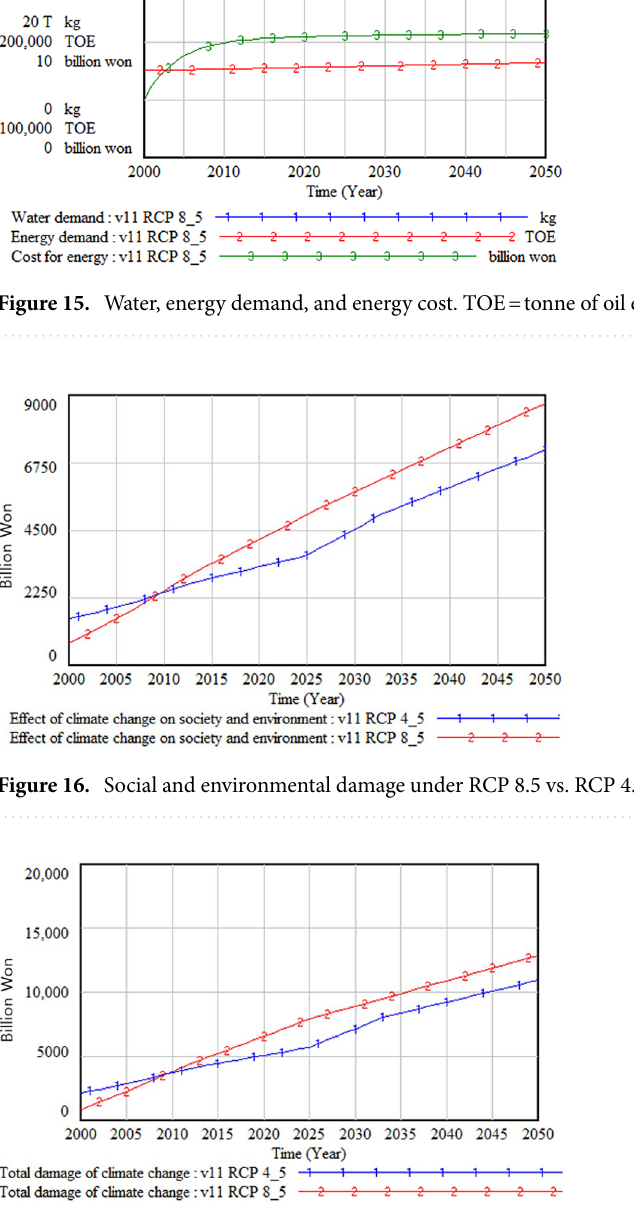
Figure 17. Total damage under RCP 8.5 vs. RCP